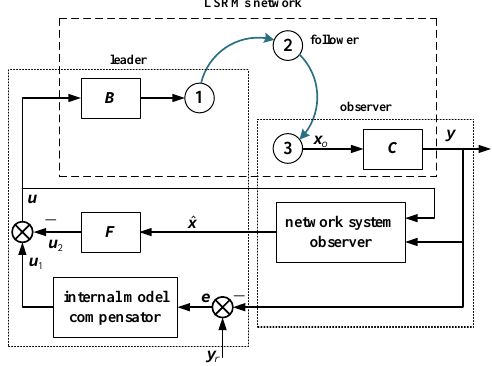
Figure 3. Control diagram of LSRM network.